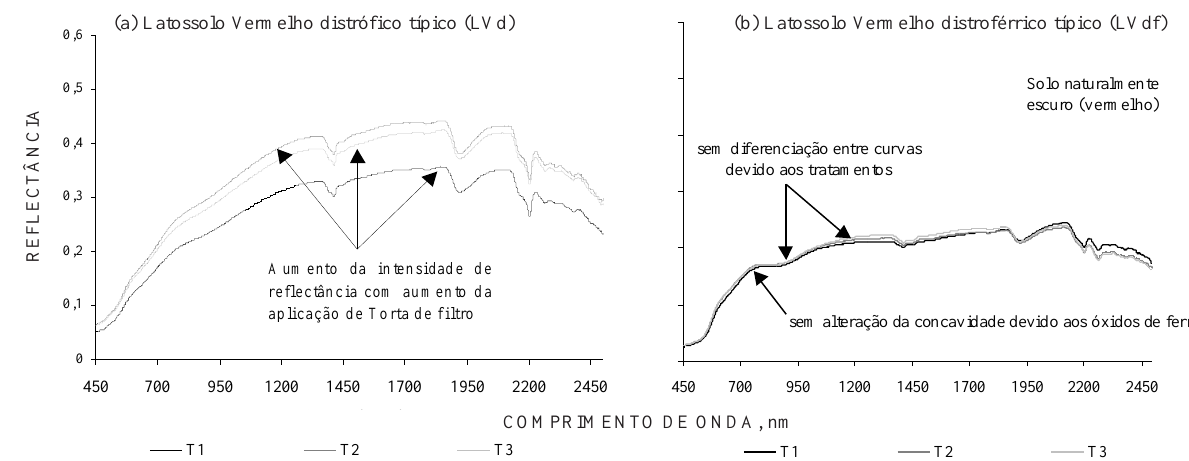
Figura 4. Curvas espectrais médias dos solos LVd e LVdf, comparando os tratamentos: T1, testemunha; T2, 40 t ha -1 ; T3, 80 t ha -1